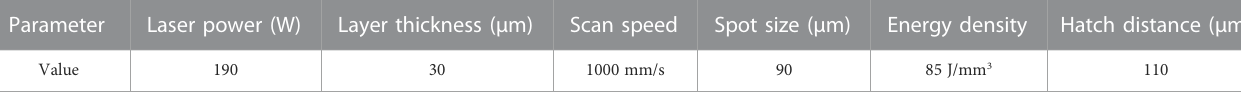
TABLE 3 Chemical composition of Ti6Al4V powder used in this study. Element C O N Standard values (mass%) Measured values (mass%)